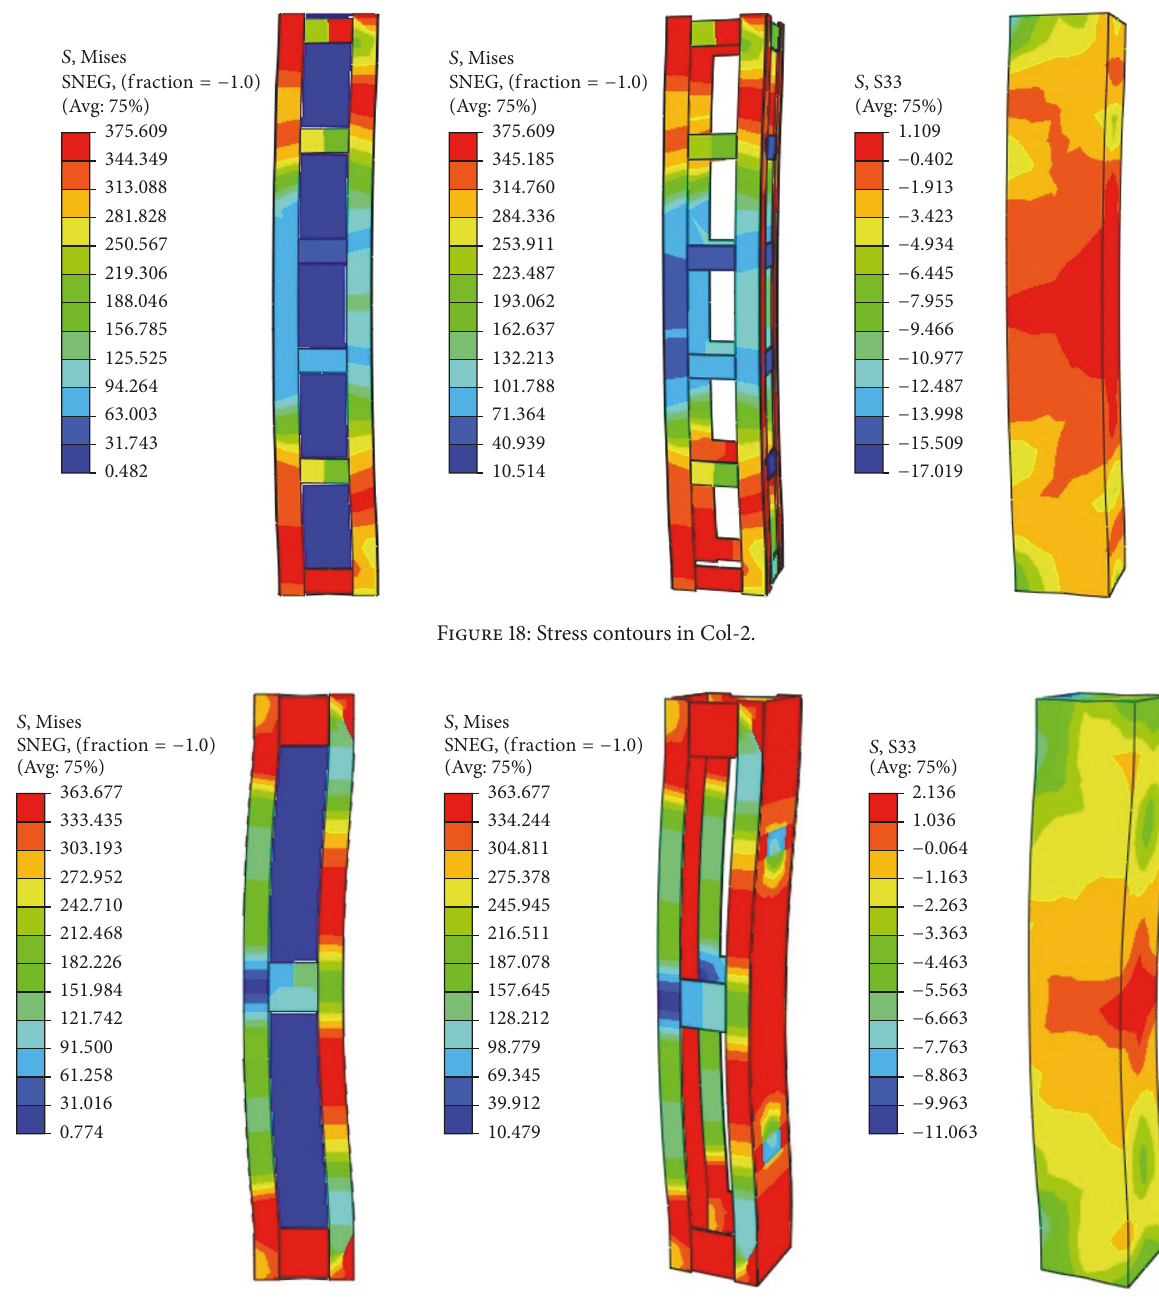
Figure 19: Stress contours in